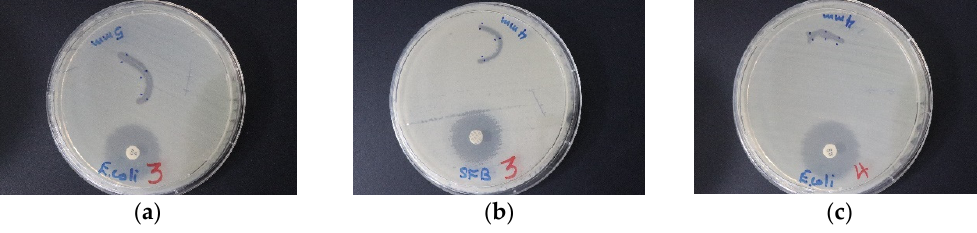
Figure 14. Antimicrobial agar plate methods of dip-coated PGA sutures. From left to right: TCA-AgNP against ( a ) E. coli WDCM 00013 ; ( b ) clinical sample Bacillus subtilis ; and ( c ) Cinn-AgNP-PI against E. coli WDCM 00013 .